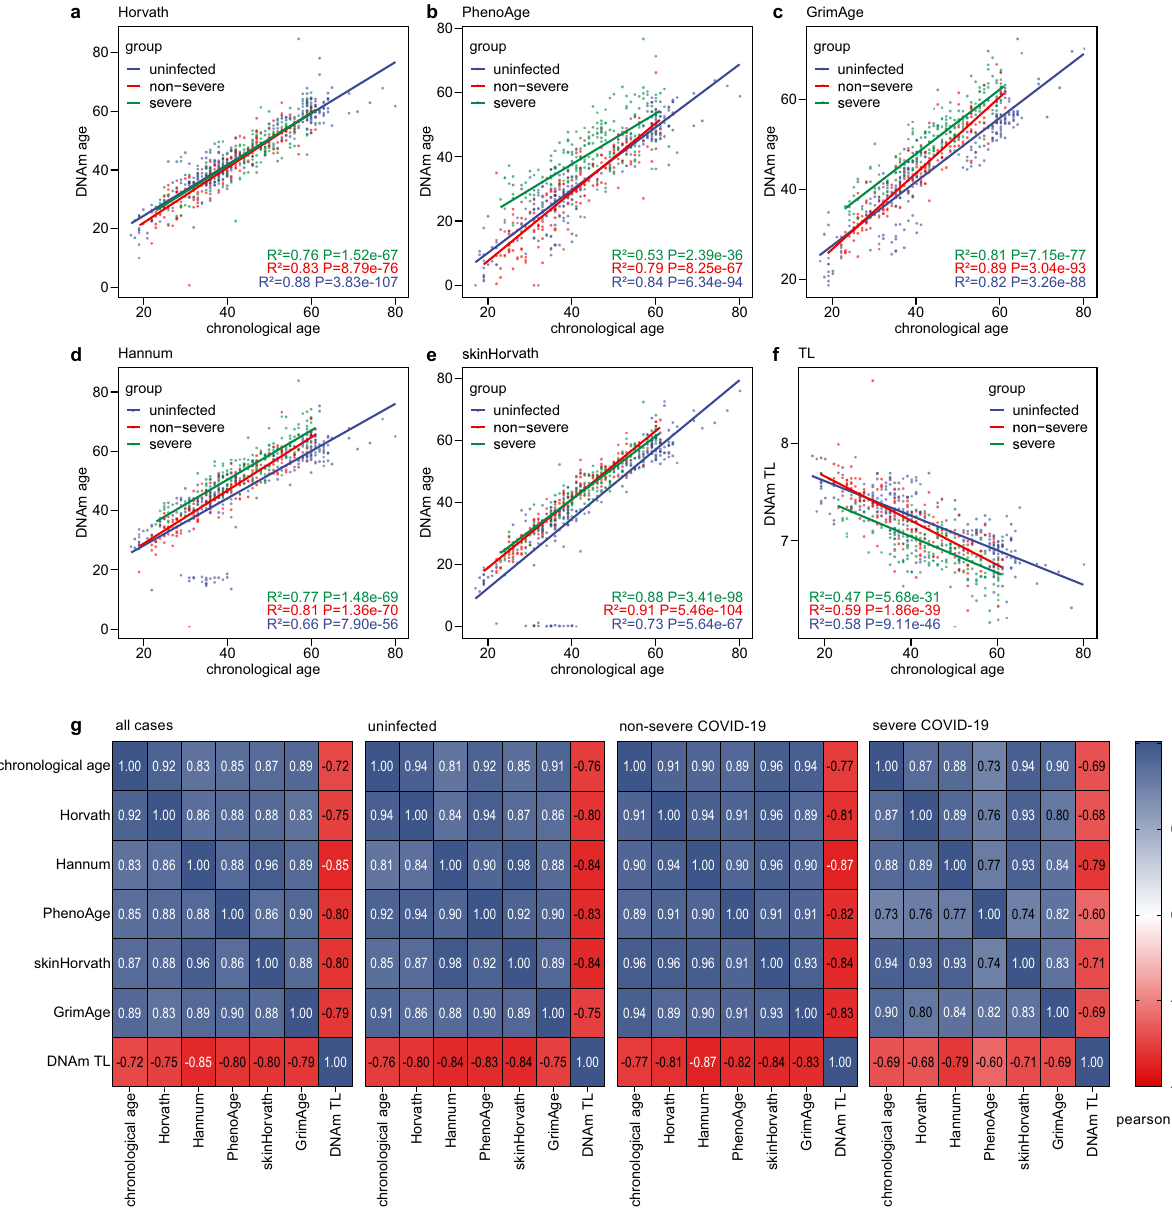
Fig. 1 Assessment of epigenetic clocks and DNA methylation-based telomere length estimator in patient cohorts. a – e Correlation of chronological age with fi ve epigenetic clocks ( a Horvath; b Hannum; c PhenoAge; d skinHorvath; e GrimAge) and DNA methylation-based telomere length ( f TL) estimator in the peripheral blood from 232 healthy individuals, 194 non-severe and 213 severe COVID-19 patients. g Heatmap presents the matrix of Pearson correlation coef fi cients among chronological age, DNAm ages determined by each epigenetic clock, and DNAm TL in the whole, healthy, non-severe and severe sets. Source data are provided as a Source Data fi